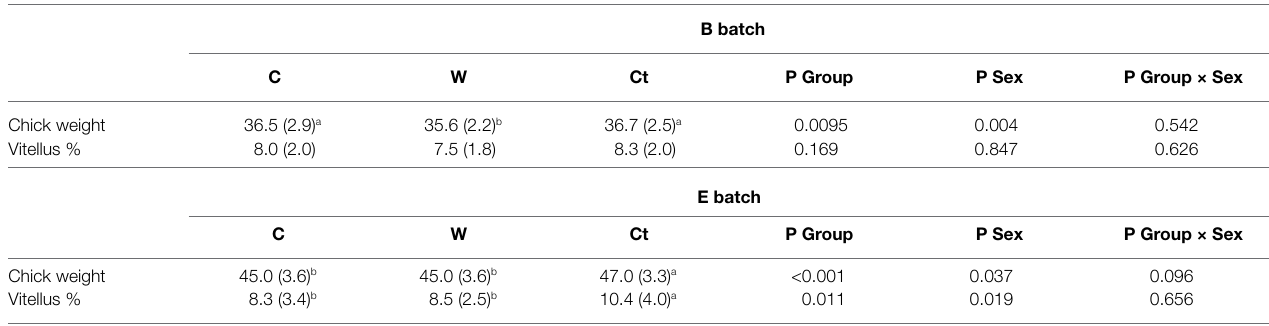
TABLE 3 | Mean (SD) of first grade chick weight (g; n = 50 chicks, by sex per group) and percentage of vitellus weight related to body weight ( n = 20 chicks, by sex per